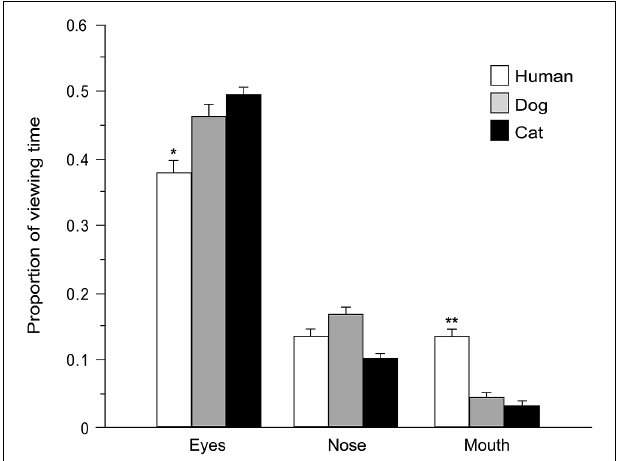
FIGURE 6 | Species-specific gaze distribution among areas of interest. Proportion of viewing time directed at eyes, nose, and mouth regions (AOIs) of different species (human, dog, and cat faces). ANOVA followed by Tukey post hoc test, ** p < 0.01 vs. dog and cat; * p < 0.05 vs. dog and cat. All data are shown as mean +